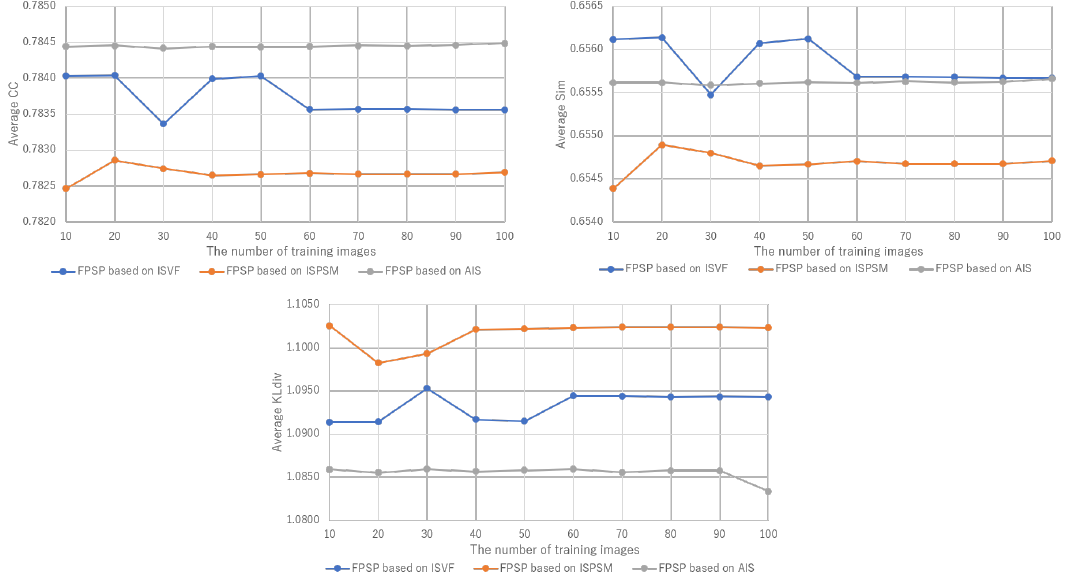
Figure 12. The prediction performance with changes in the number of training images. The robustness of FPSP based on AIS is